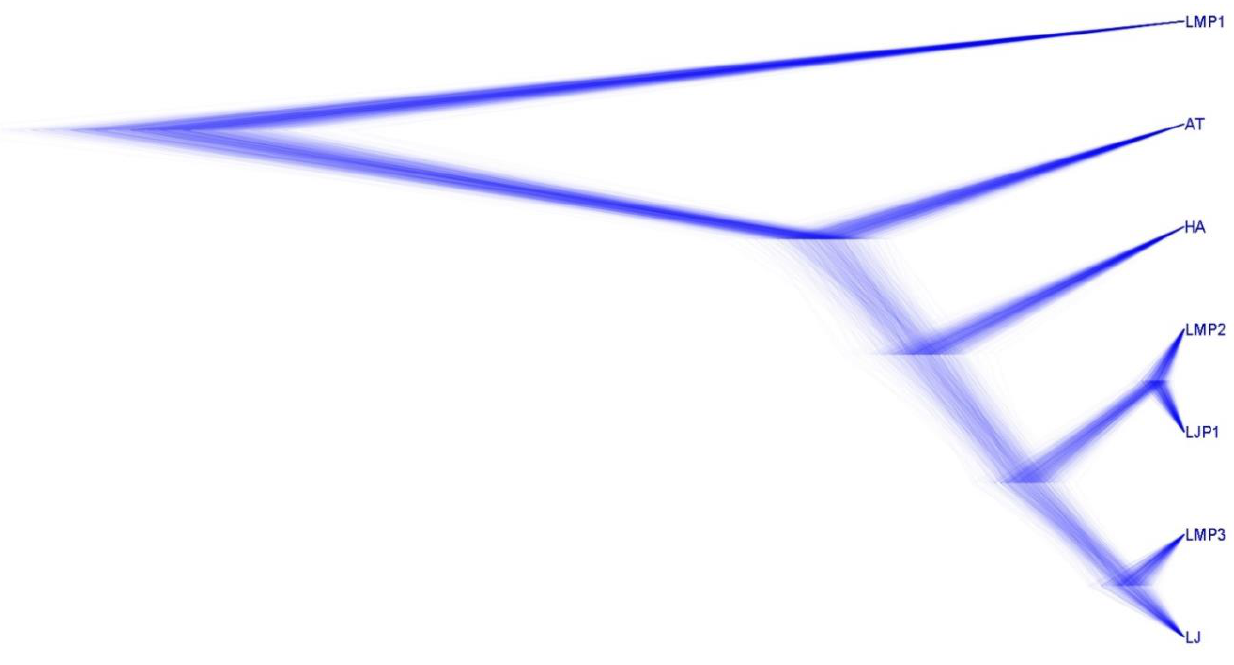
Figure 3. Maximum likelihood tree for predicted protein sequences. Derived species are identified by abbreviation (AT— A. thaliana , HA— H. annuus , LM— L. maackii , and LJ— L. japonica ). “P” annotates protein sequences predicted by sequence homology.